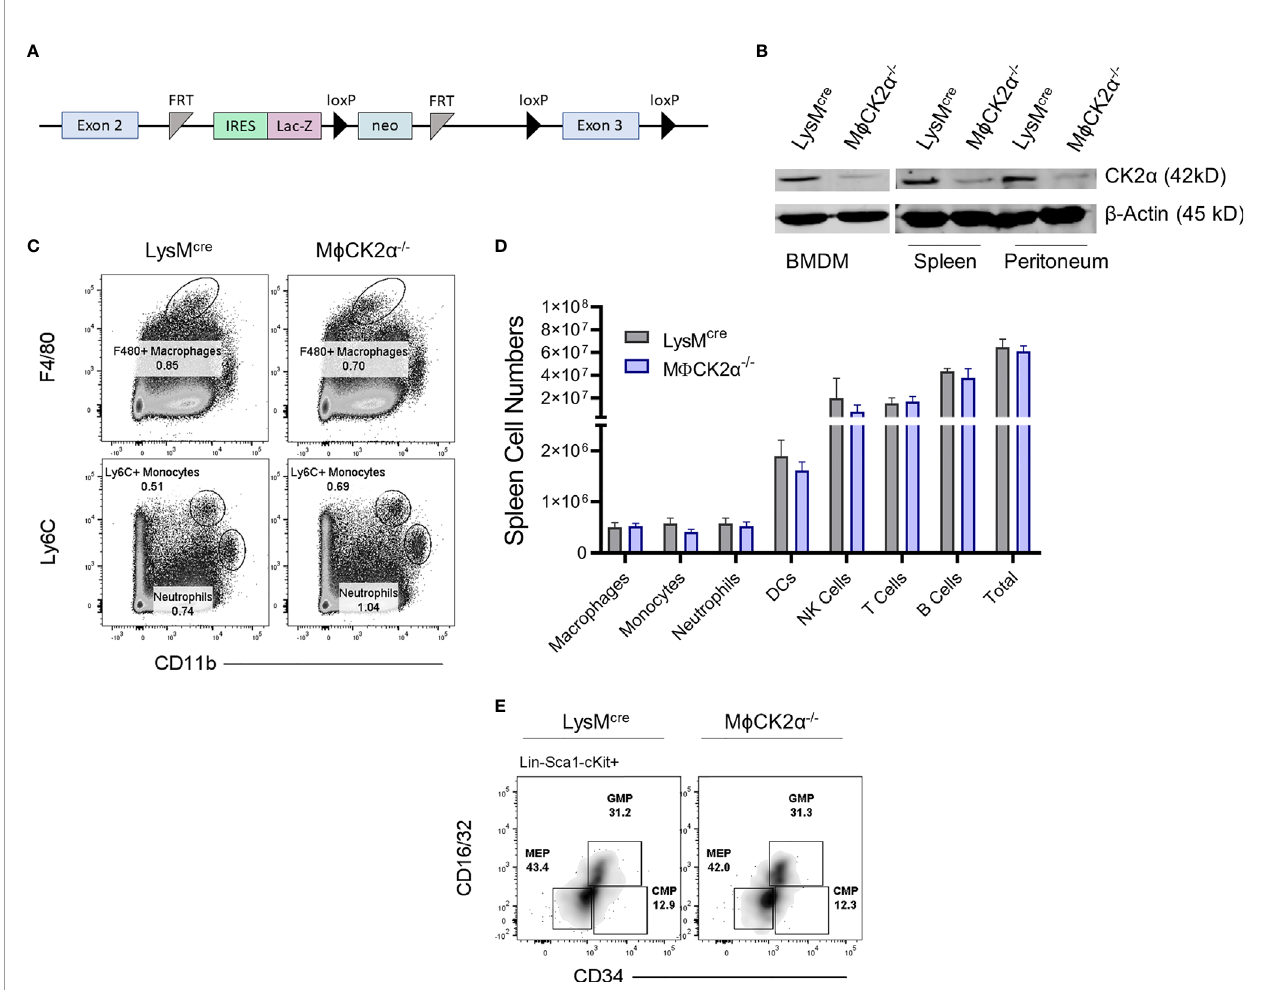
FIGURE 1 | Development of myeloid cell populations is not detectably altered in M f CK2 a − / − mice. (A) Schematic of Csnk2a targeting vector. (B) Immunoblots of lysates from BMDMs, splenocytes, or peritoneal cavity cells of LysM cre or LysM cre CK2 a fl / fl (M f CK2 a − / − ) mice were probed for CK2 a or b -actin as a loading control. n = 2. (C) Splenic myeloid cell populations were stained and analyzed by fl ow cytometry. Plots depict gating for representative F4/80+ macrophages, Ly6C+ monocytes, and neutrophils (also Ly6G+). (D) Cells from spleen were stained for fl ow cytometry to enumerate immune cell populations. Data are from pooled experiments, n = 4 – 12 mice/group. (E) Cells from bone marrow were stained for fl ow cytometry to evaluate bone marrow precursor populations including common myeloid progenitors (CMPs), granulocyte-monocyte progenitors (GMPs), and megakaryocyte-erythrocyte progenitor (MEP). Cells were pre-gated on Lin-(B220, CD3, CD11b, GR-1 and TER-119), Sca-1-, cKit-. Density plots are representative from two